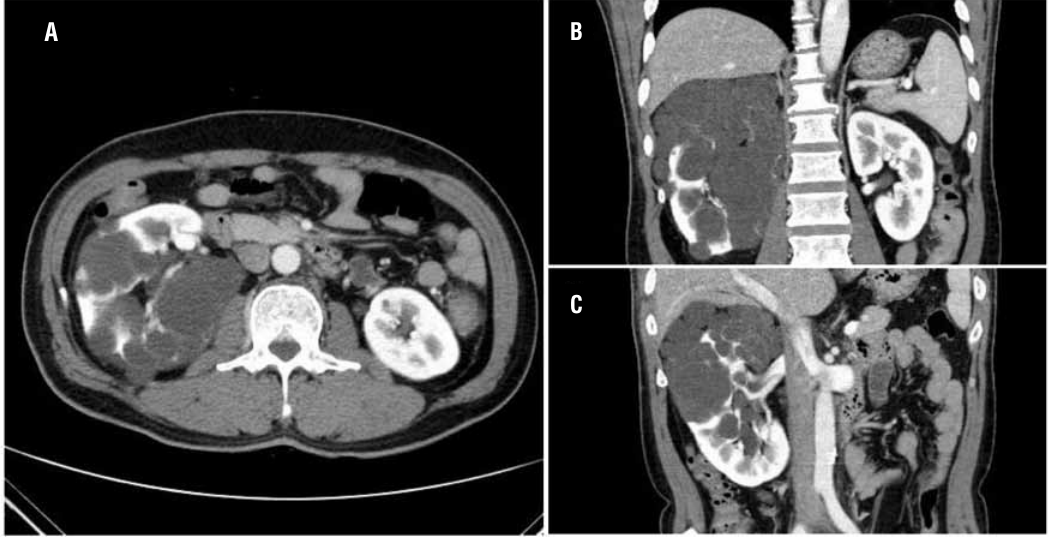
Figure 1 - Preoperative axial (A) and coronal scan (B, C) of abdominal CT showing multiple cysts in the right